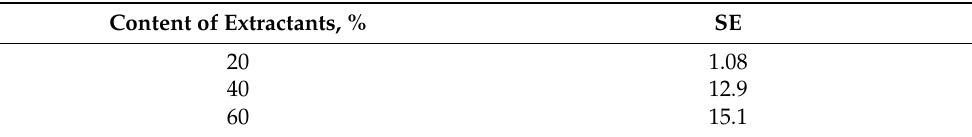
Table 3. The values of synergy effect (SE) for recovery of Nd(III) from HNO 3 of 0.001 mol/L by